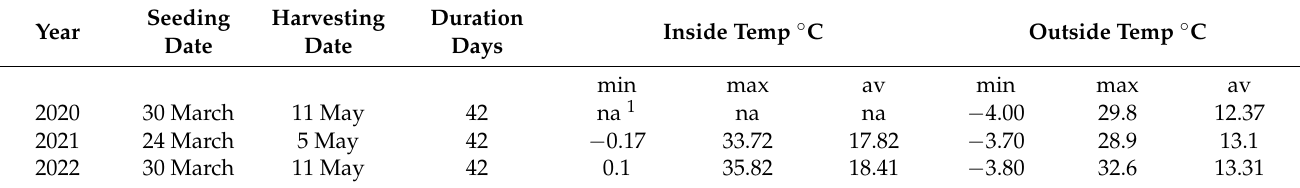
Table 1. Seeding and harvesting dates, duration, and maximum, minimum, and average